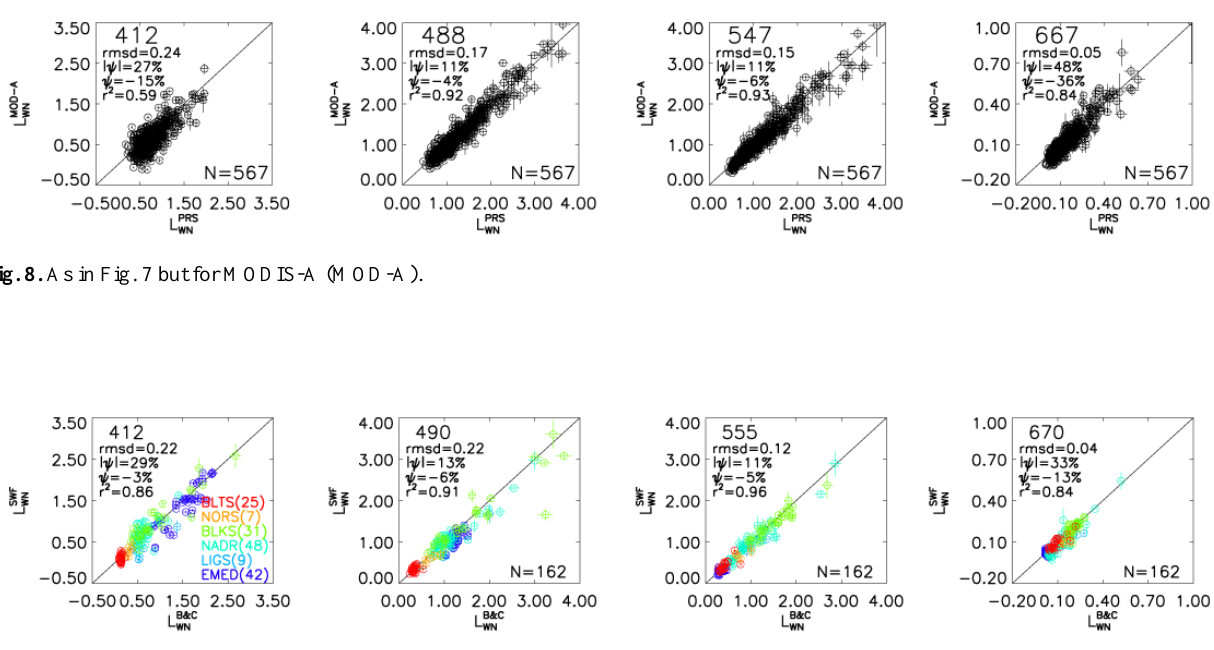
Fig. 9. Scatter plots of SeaWiFS (SWF) versus BiOMaP and CoASTS (B&C) L WN at selected center wavelengths for match-ups determined with 1t =± 4h. Symbols and units are the same as in Fig. 1. Different colors identify different seas: Baltic Sea (BLTS), North Sea (NORS),